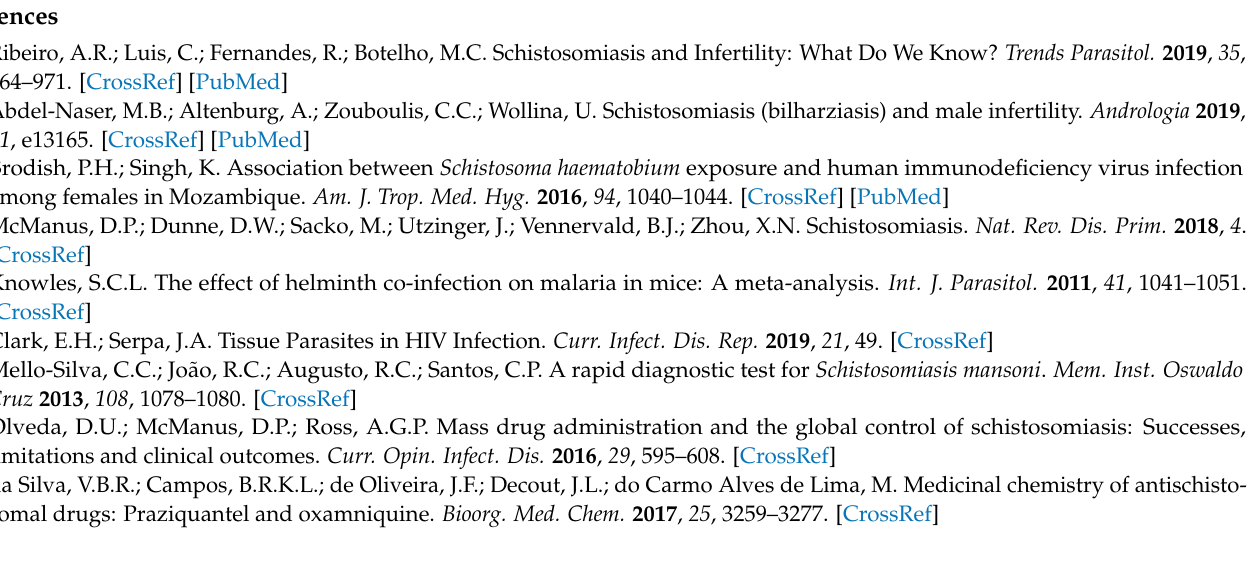
Table S5: Two-way ART ANOVA interaction effects, comparing the effects of S. mansoni cercarial exposure to NP1, NP5, NP7, and NP8 at 0.1 mg/mL in MilliQ water one min pre- and post-exposure. Metrics: active velocity, active angular SD, relative number of passive points and states. If the interaction effect was significant, pairwise contrasts testing analysed the significance of change in behaviour pre- vs. post-exposure between MilliQ and each of the putative neuropeptides. Table S6: Behavioural bioassay guided data, including points data from S. mansoni cercariae pre-exposure and 90 min, 180 min, 270 min, and 360 min post-exposure to NP1, NP5, NP7, and NP8 at 3 mg/mL and MilliQ water. Table S7. pH of MilliQ water and all neuropeptide solutions (59 µ g/mL) measured using a TPS pH Cube pH-mV-Temp